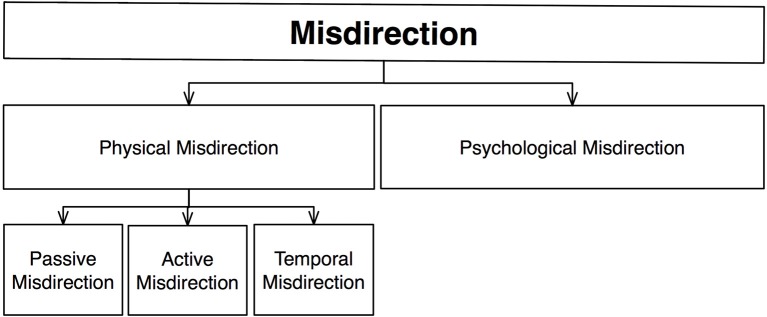
Schematic diagram of Lamont and Wiseman's (1999) taxonomy.